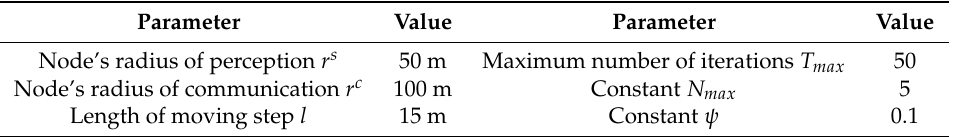
Table 1. Simulation